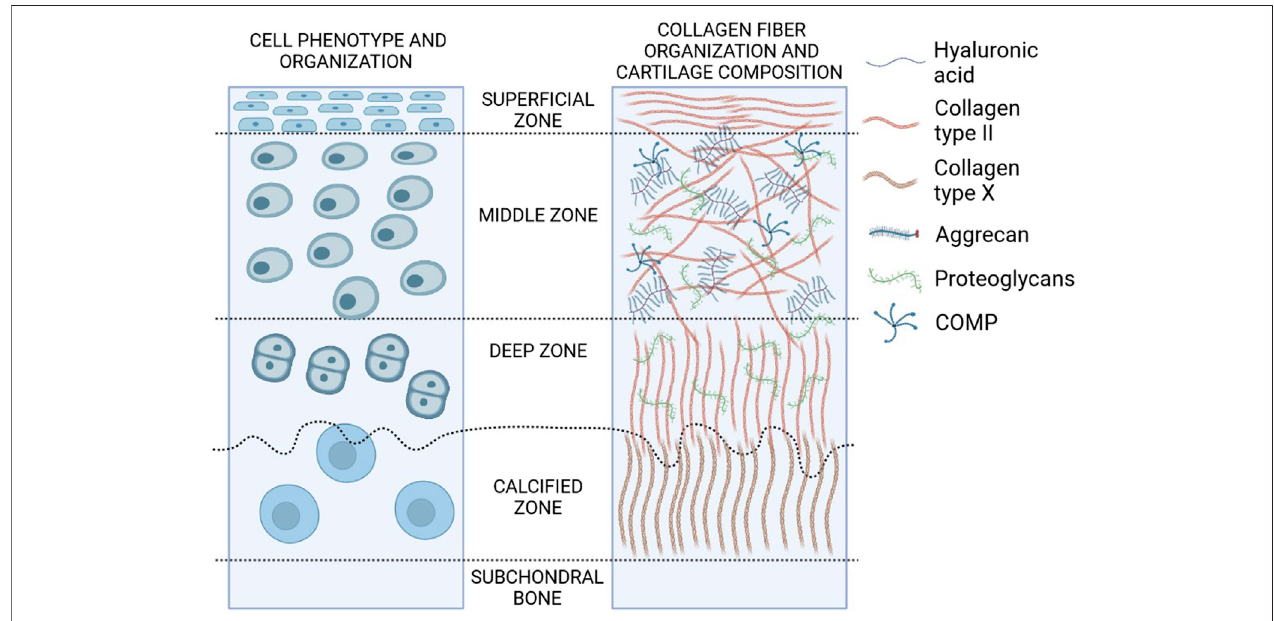
FIGURE 2 | Structure and composition of hyaline cartilage. Zones of hyaline cartilage with varying cellular distribution, shape, collagen organization, and biochemical markers are depicted in this diagram (created in BioRender.com).